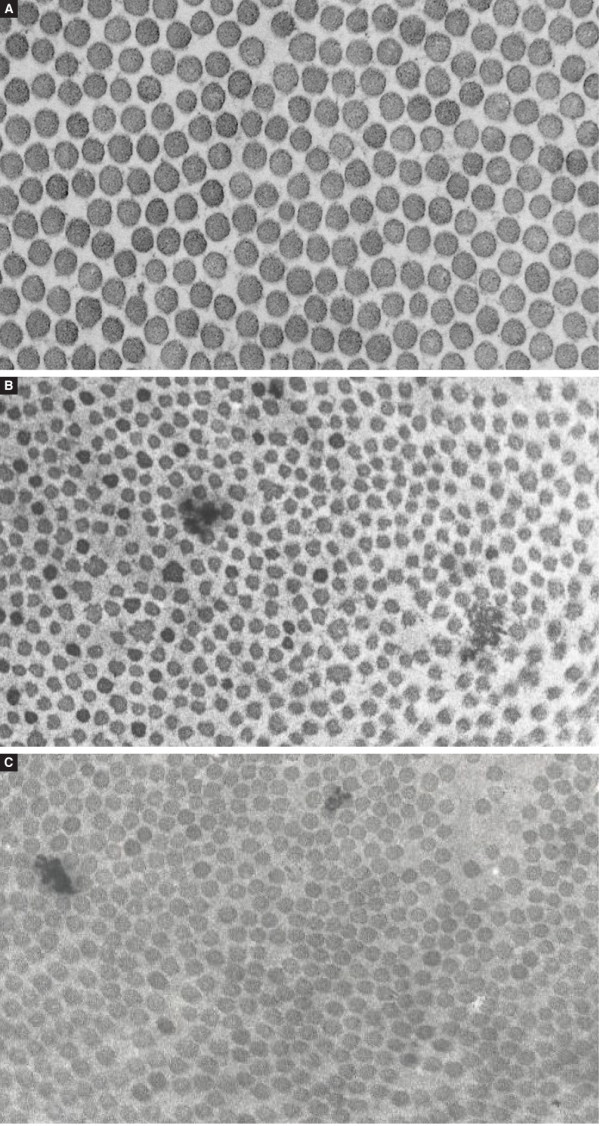
Transmission electron microscopy of collagen dermal fibrils. A: Normal control. Fibril diameter is 97,1 +/- 8,1 nm (original magnification 45.000x). B: EDS arthrochalasis subtype (VIIB): complete retention of the N-propeptide of the α2(I)-procollagen chain is caused by skipping of the N-proteinase cleavage site itself, resulting in incorporation of pN-collagen molecules into the collagen fibrils in the extracellular matrix. This causes loss of the normal collagen fibril morphology, with decreased fibril density, decreased fibril diameter (43.82 +/- 6.09 nm), irregular contours and occasional cauliflowers (original magnification 45.000x). C: OI/EDS-proband P3: The N-proteinase cleavage site remains intact, but processing of the type I procollagen N-propeptide is delayed, resulting in abnormal collagen fibrils, with irregular borders and diameters (73.01 +/- 5.88 nm) that are smaller than those from controls but larger than for patients with EDS arthrochalasis type. Fibril contours are only slightly irregular and fibril density is decreased (original magnification 45.000×).